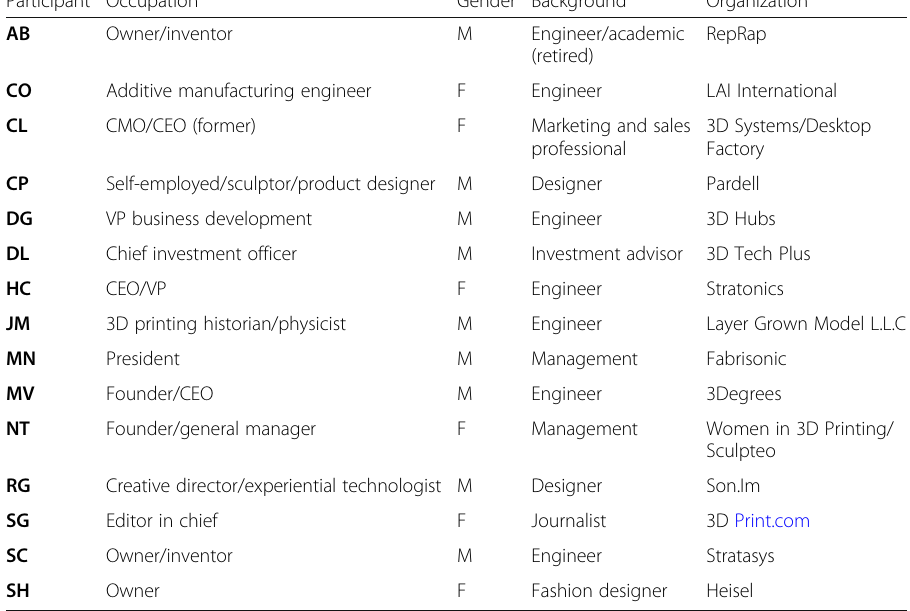
Participant Occupation Gender Background